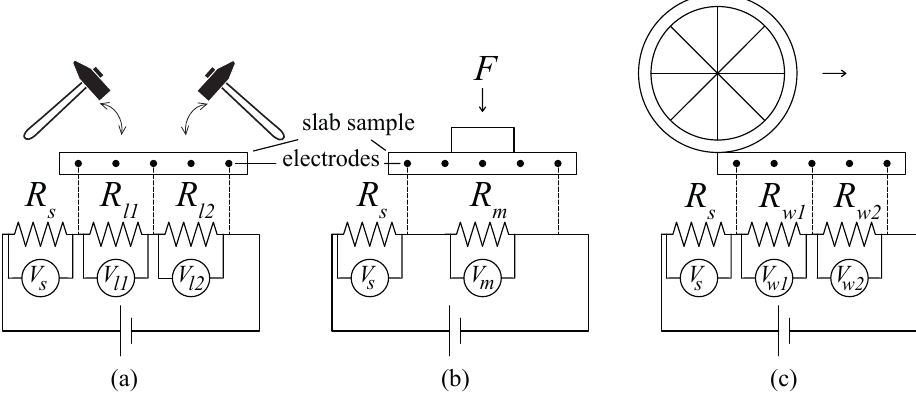
Figure 3. The equivalent circuit models for: ( a ) the LL case; ( b ) the LM case; and ( c ) the WF case. The LL case (Figure 3a) has a shunt resistor R s = 1 M Ω connected in series with the pavement sample. The circuit is powered using a DC analog input ( V i ) and three voltage time history values are recorded, V s ( t ) , V l 1 ( t ) , and V l 2 ( t ) , where V s is the voltage drop through the shunt resistor, V l 1 is the voltage drop through the first half of the sample, recorded voltage time histories are V m ( t ) , V w 1 ( t ) and V w 2 ( t ) , where V m is the voltage